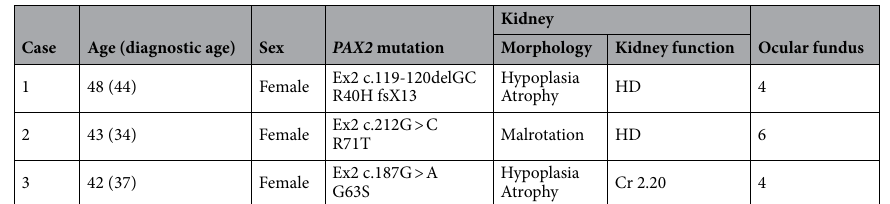
Table 1. Clinical and genetic information of patients with renal coloboma syndrome (RCS). The ocular fundus score was evaluated based on the methods described in previous studies 14 . The score of ocular fundus: Score 0, normal optic disc; Score 1, optic disc dysplasia with an unusual pattern of the retinal vessels and cilioretinal arteries; Score 2, optic disc pit associated with vascular abnormalities and cilioretinal artery; Score 3, large coloboma involving the entire surface of the optic disc; Score 4, large coloboma of the optic disc and adjacent retina or morning glory anomaly (with radial emergence of the retinal vessels) 14 . HD hemodialysis, Cr serum creatinine, Ex